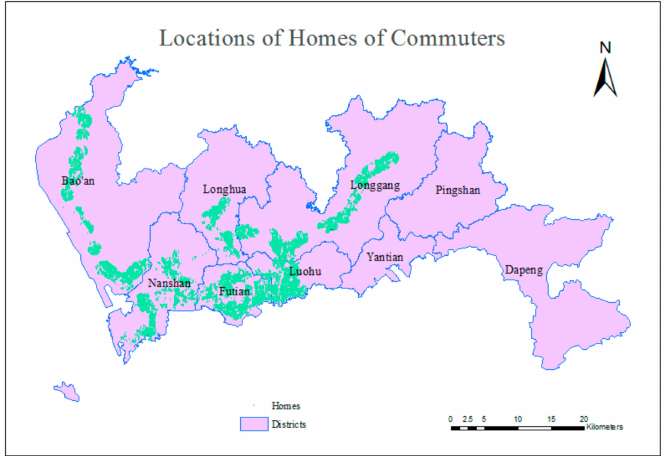
Figure 6. Locations of the homes of selected citizens.